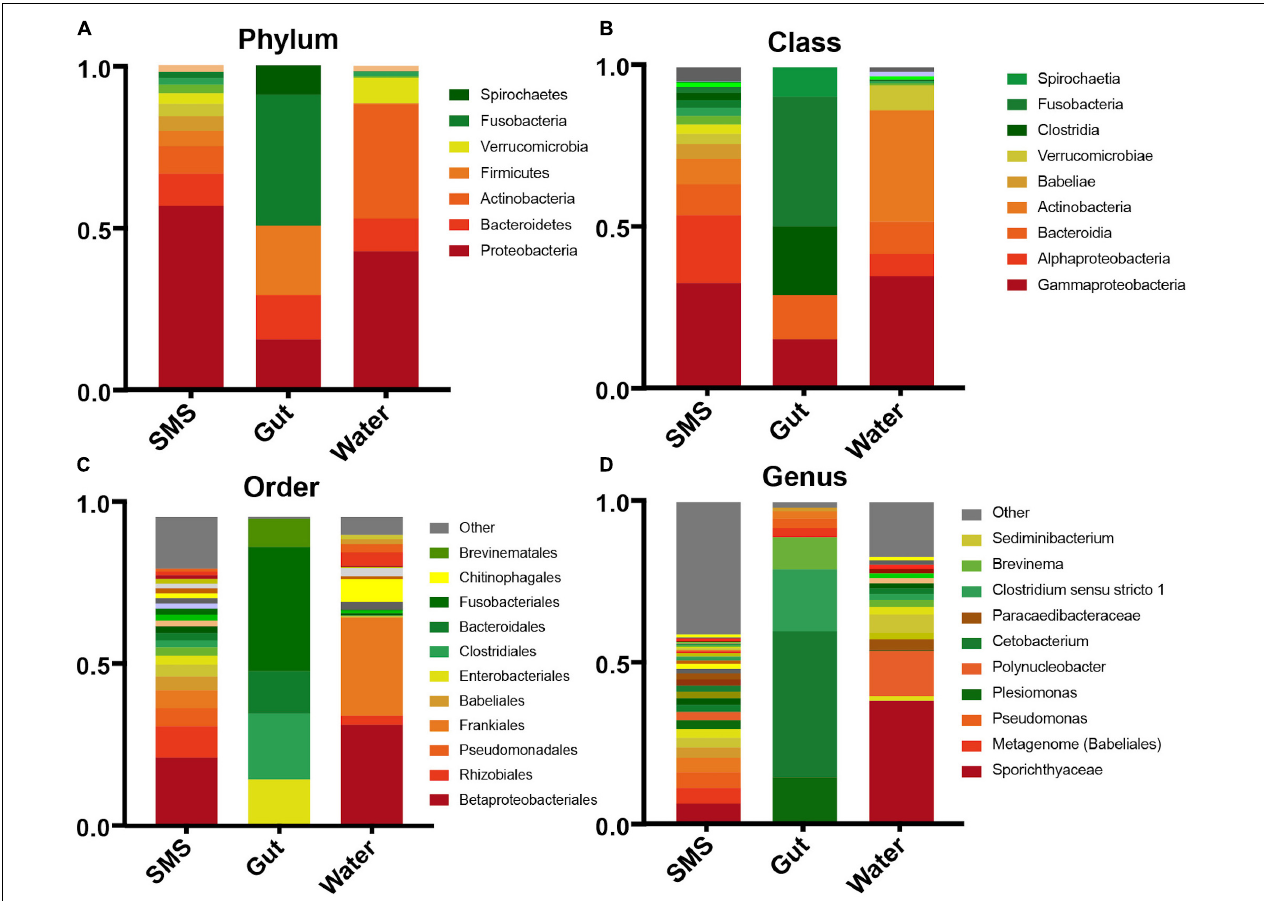
FIGURE 2 | Taxonomic abundances within the SMS, Gut, and Water. Relative abundances across communities in descending taxonomic level; Phyla (A) , Class (B) , Order (C) , and Genus (D) . Taxonomic groups with abundances less than 0.001% are contained within